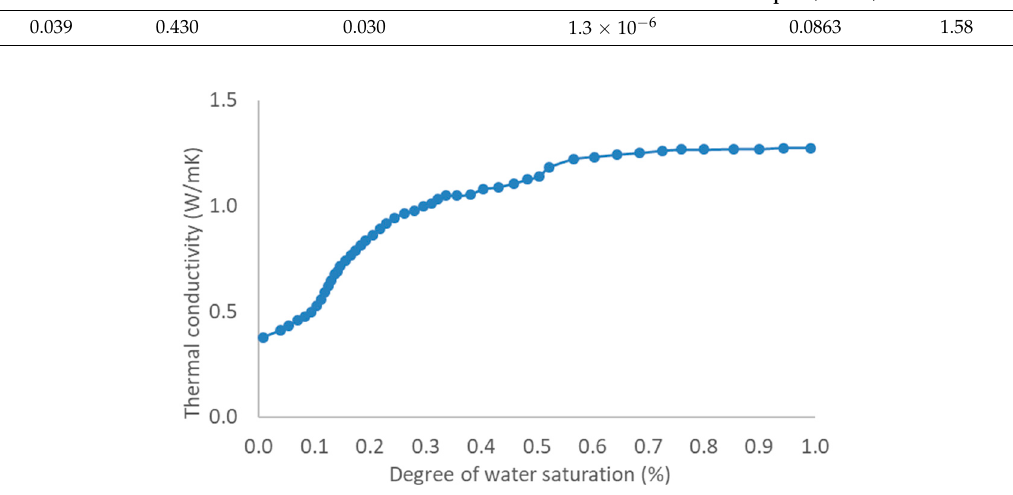
Figure A1. Thermal conductivity-Saturation curve for Bonny Silt.